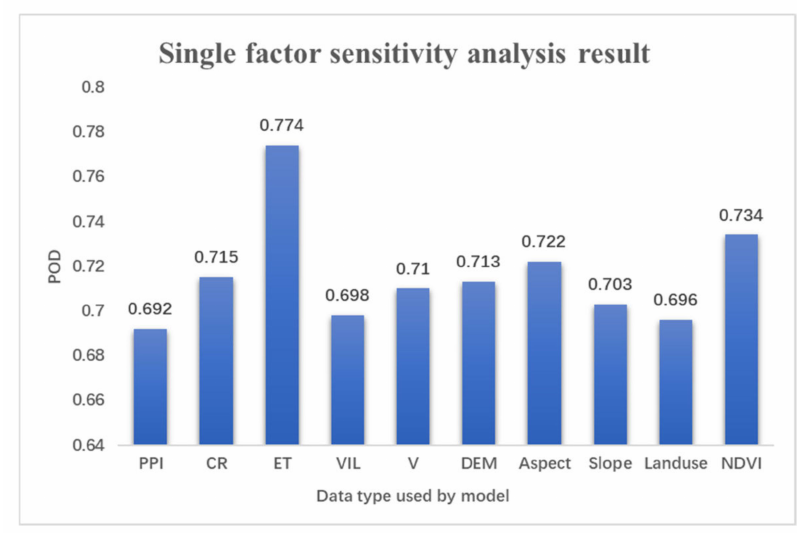
Figure 8. Single factor sensitivity analysis by the LM-ResNet model.